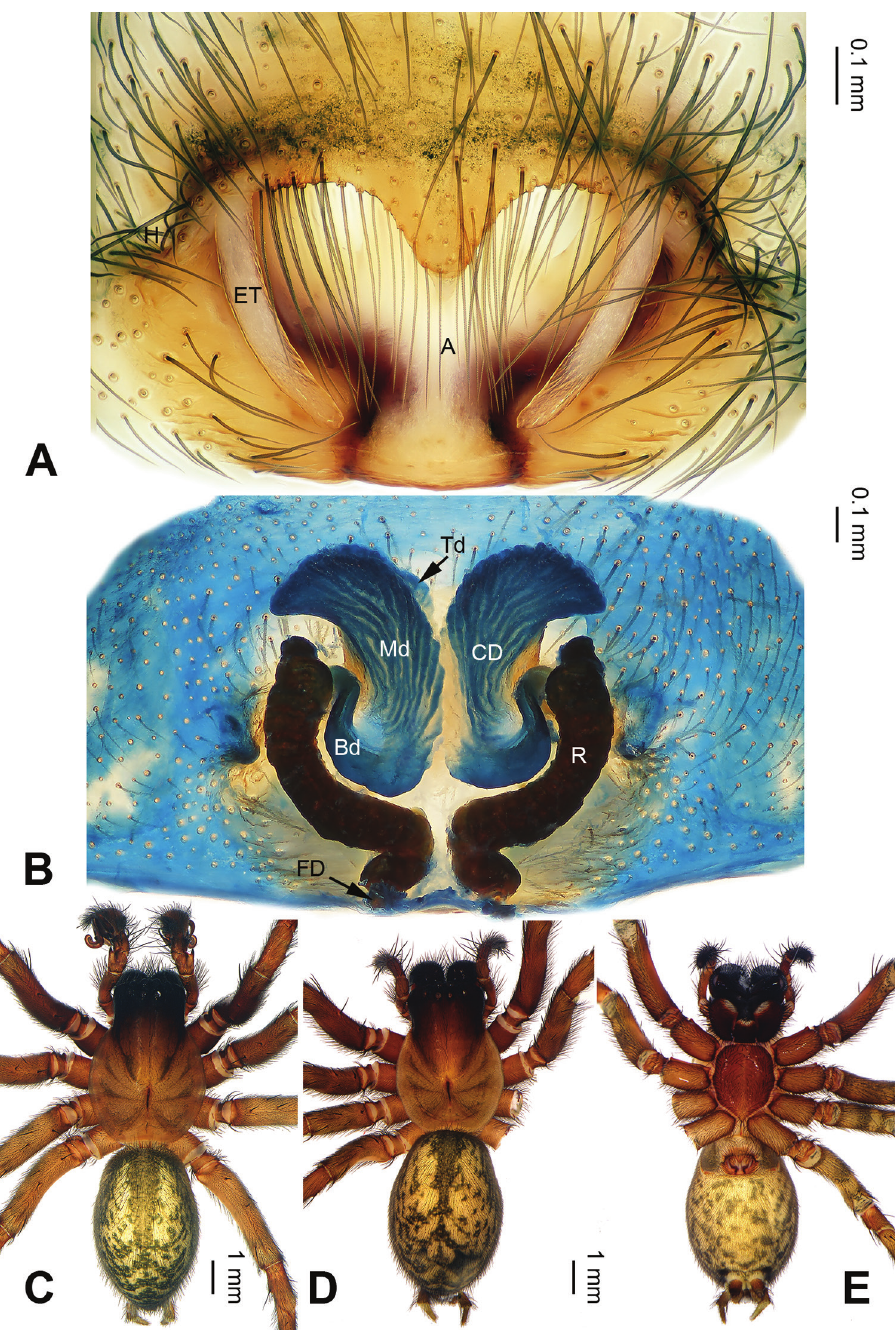
Figure 4. Pireneitega liansui , specimens from Diaoxian. A Epigyne, ventral view B Vulva, dorsal view C Male habitus, dorsal view D Female habitus, dorsal view E Female habitus, ventral view. Scale bars: equal for D, E